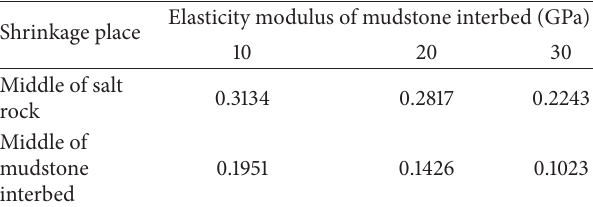
Table 6: The radial displacement of shrinkage per unit time under different elasticity modulus of mudstone interbed